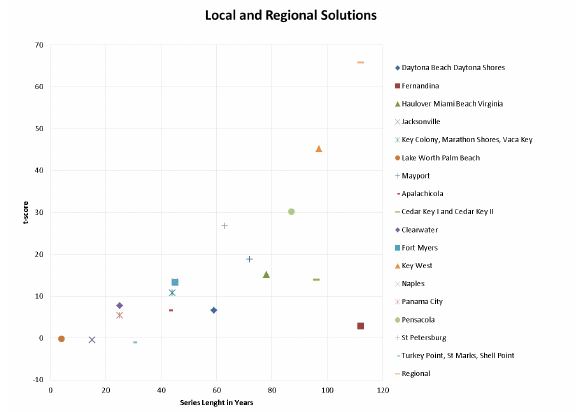
Figure 3. Themarkedimpactofrigorousregionalsolutionisrevealed byt-values(signaltonoiseratios)calculatedbydividingthe estimated trends by their standard